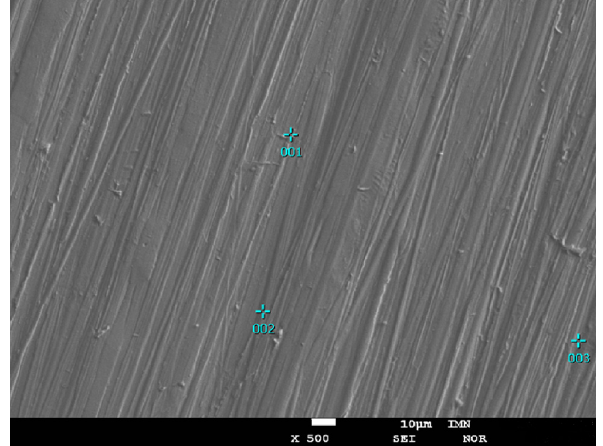
Figure 2: Surface morphology of the Ni – 37Re coating ( j = 25 mA · cm − 2 , 5 g · L − 1 of ammonium rhenate ( VII ) in the bath ) with the three points of EDS